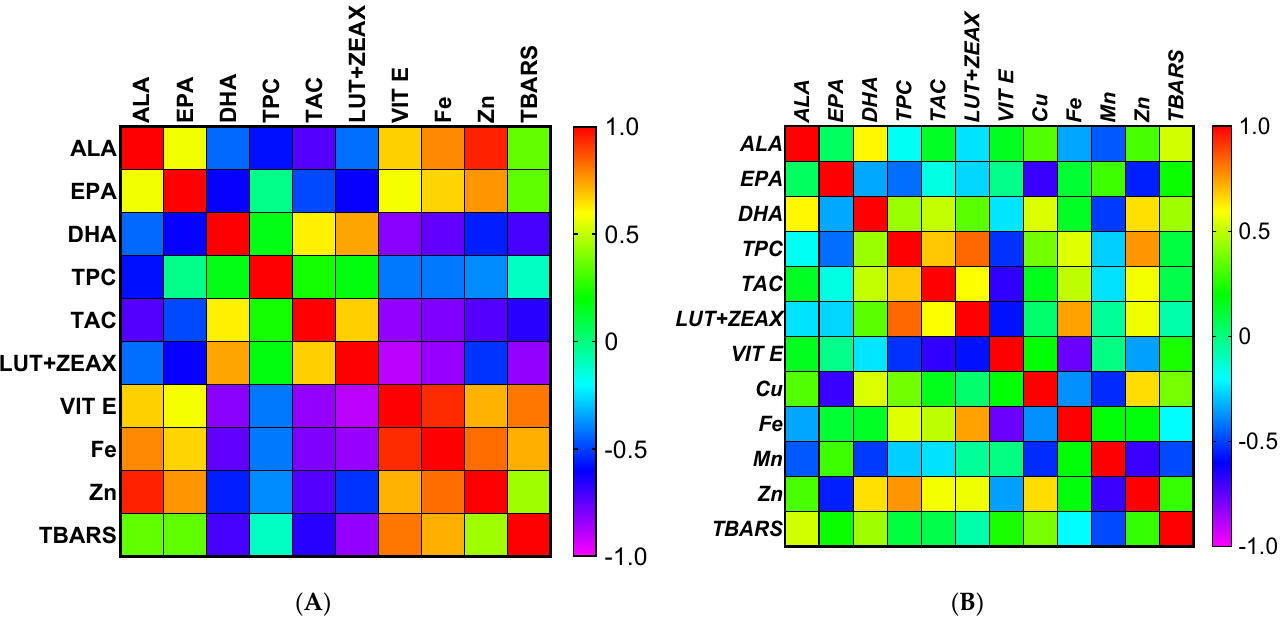
Figure 5. Heatmaps representing the correlation between meat quality characteristics in breast ( A ) and thigh meat ( B ). Each cell contains the corresponding correlation and is color‑coded by the cor‑ relation according to the color legend on the left, where red indicates a strong positive correlation and violet indicates a strong negative correlation. The stronger the correlation, the darker is the color. Abbreviations: ALA—alfa-linolenic acid; EPA—eicosapentaenoic acid; DHA—docosahex- aenoic acid; TPC—total phenolic content; TAC—total antioxidant capacity; and TBARS—thiobarbi- turic reactive species. T0: control diet; T1: treatment with 0.00002% Cr; and T2: experimental diet supplemented with 0.00002% Cr +2% sea buckthorn leaves (SBL).